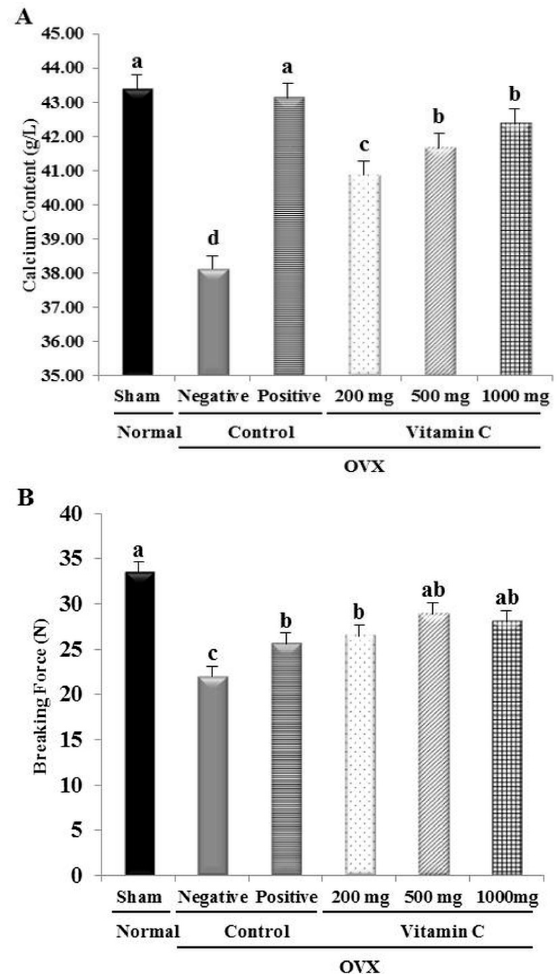
Figure 2. Vitamin C-related increase in calcium content and breaking force in ovariectomized (OVX) rat tibias: ( A ) Calcium content of rat tibias; ( B ) breaking force of rat tibias. Values represent the mean ± standard deviation. Values with different letters were significantly different according to Duncan’s multiple range test ( P < 0.05).